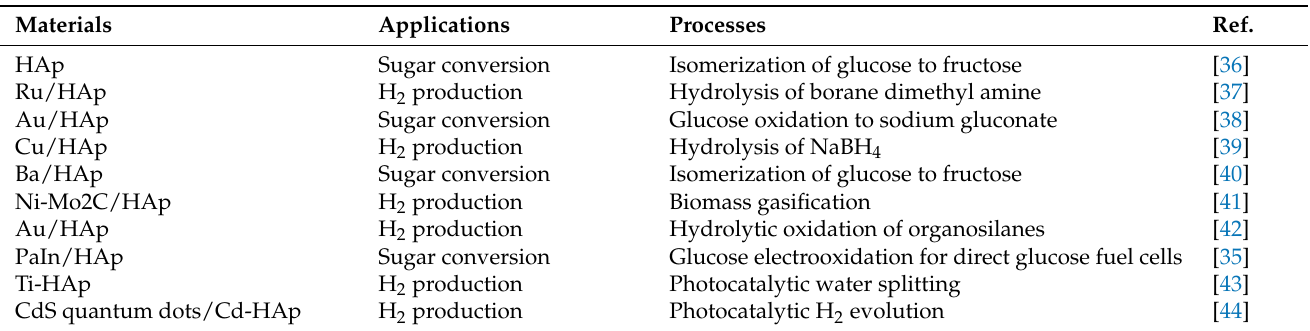
Table 1. Recent reports of using hydroxyapatite (HAp)-based materials for H 2 production and sugar